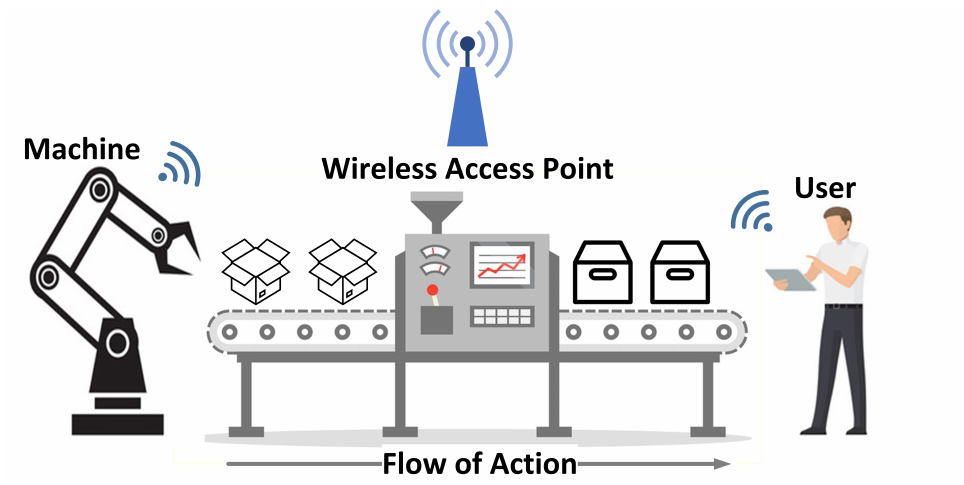
Figure 5. An automated production assembly line where the user is giving instructions wirelessly on a tablet in